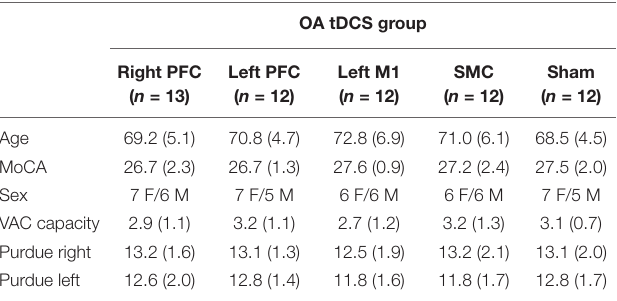
TABLE 2 | Mean (SD) transcranial direct current stimulation (tDCS) group scores of age, MoCA, sex, Purdue Pegboard, and spatial working memory capacity (visual array capacity) for older